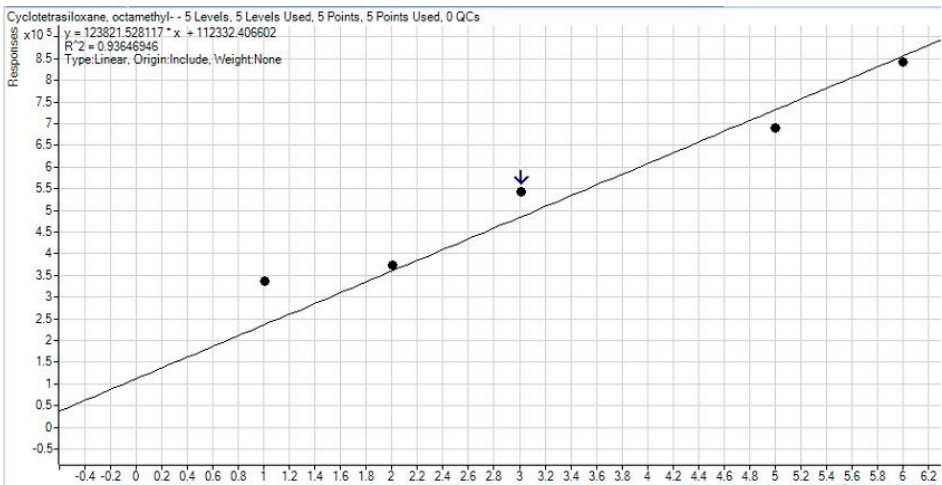
Figure 3. Calibration line for D4.